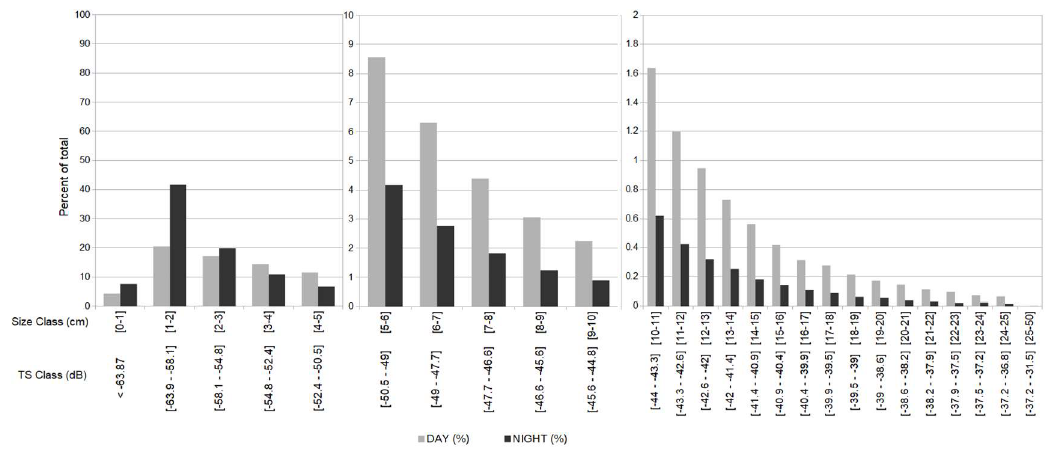
Figure 11. The size (total length, cm) and Target Strength (dB) distribution of pelagic fish recorded during night and day vertical surveys in Lake Trichonis.